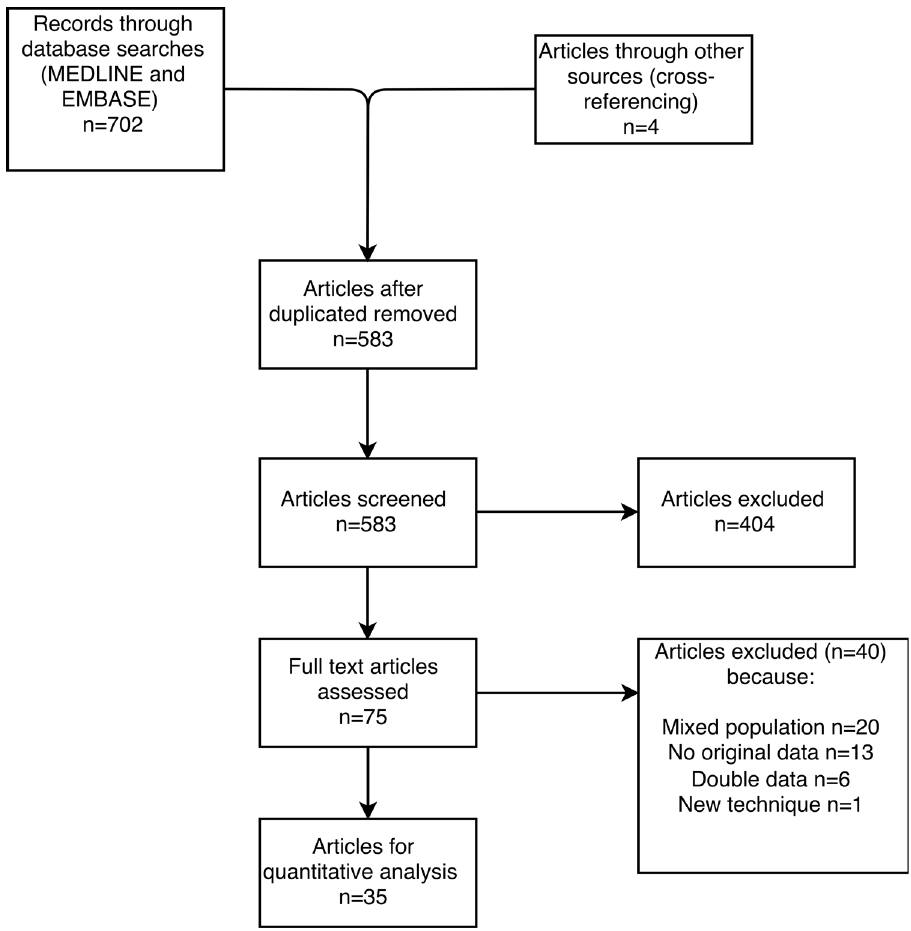
Fig 1. Flowchart of article